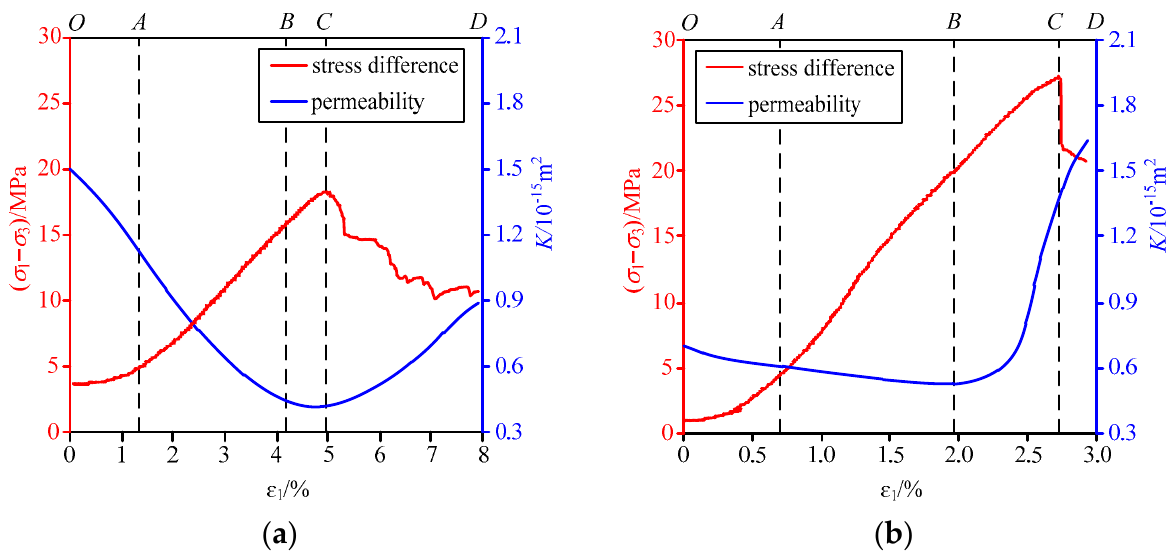
Figure 6. Axial pressure-permeability-strain curves of briquette and raw coal. ( a ) Briquette; ( b ) raw coal.